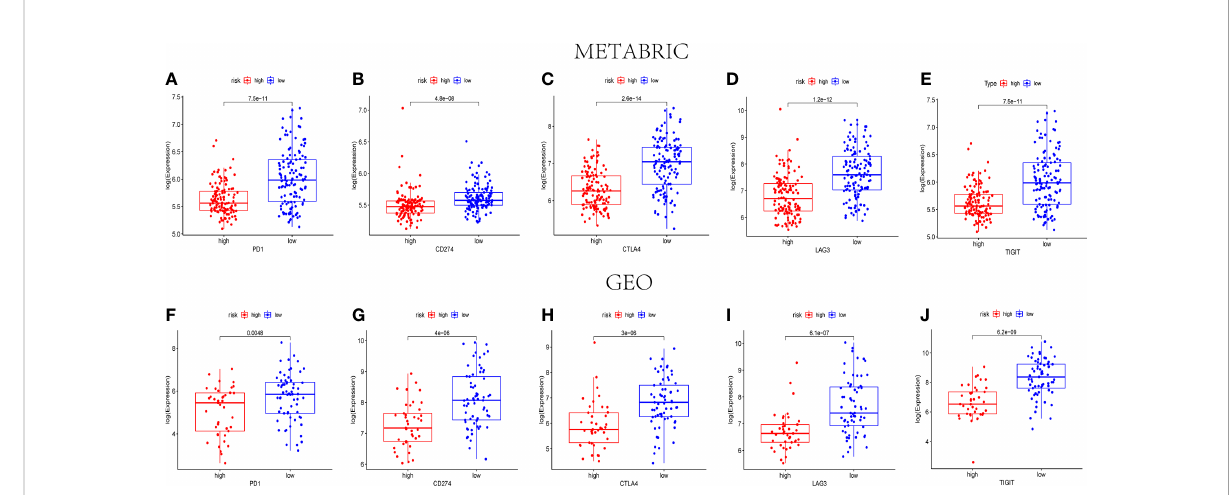
FIGURE 8 The expression levels of immune checkpoint – related genes between the high- and low-risk groups. The expression levels of PD1 (A) , CD274 (B) , CTLA4 (C) , LAG3 (D) , and TIGIT (E) in different risk groups of the METABRIC set (P< 0.05). The expression levels of PD1 (F) , CD274 (G) , CTLA4 (H) , LAG3 (I) , and TIGIT (J) in different risk groups of the GEO set (P<